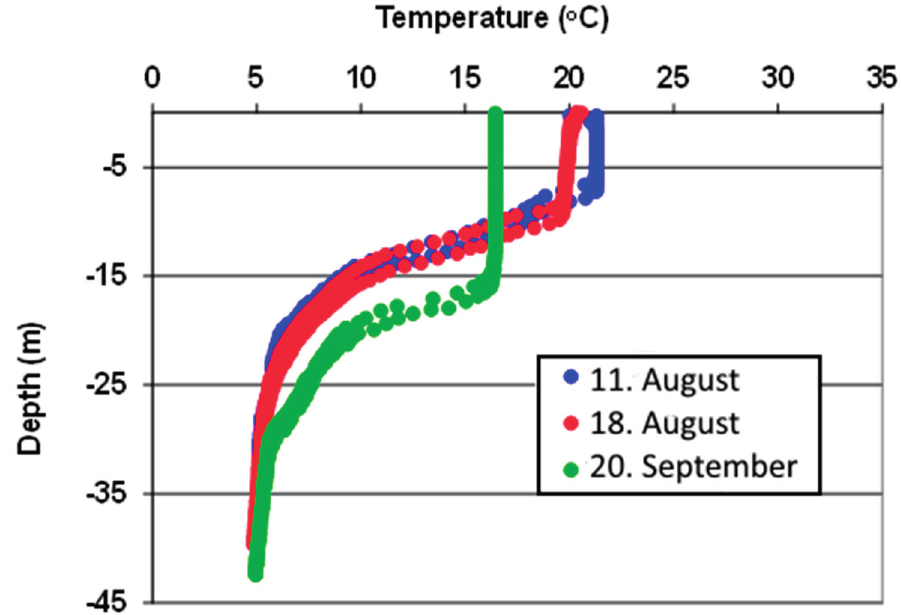
Figure 2. Typical vertical temperature distributions in Lake Maridalsvannet during the summer. The figure is based on temperature measurements above the raw water intake three days in